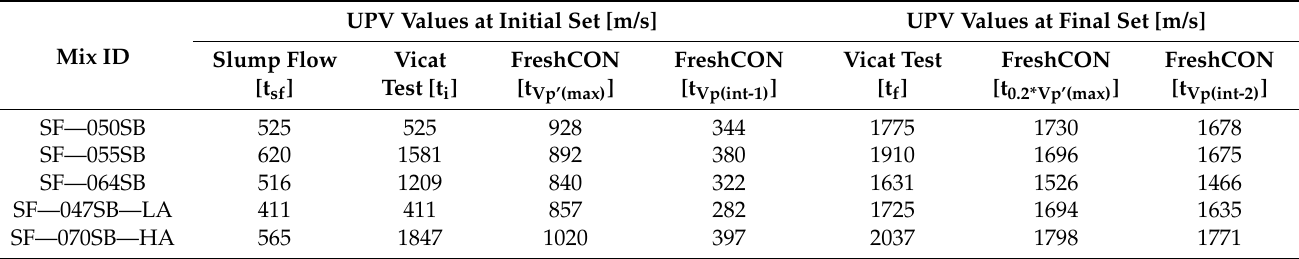
Figure 9. P-wave velocities that correspond to the setting times determined by slump flow tests, Vicat tests, and UPV tests, plotted for all five mixes. Hollow markers with dashed lines depict the initial setting, while solid markers with solid lines show the final setting. Table 7. Summary P-wave velocity that corresponds to the setting times determined by slump flow tests, Vicat tests, and UPV tests, plotted for all five mixes [m/s].